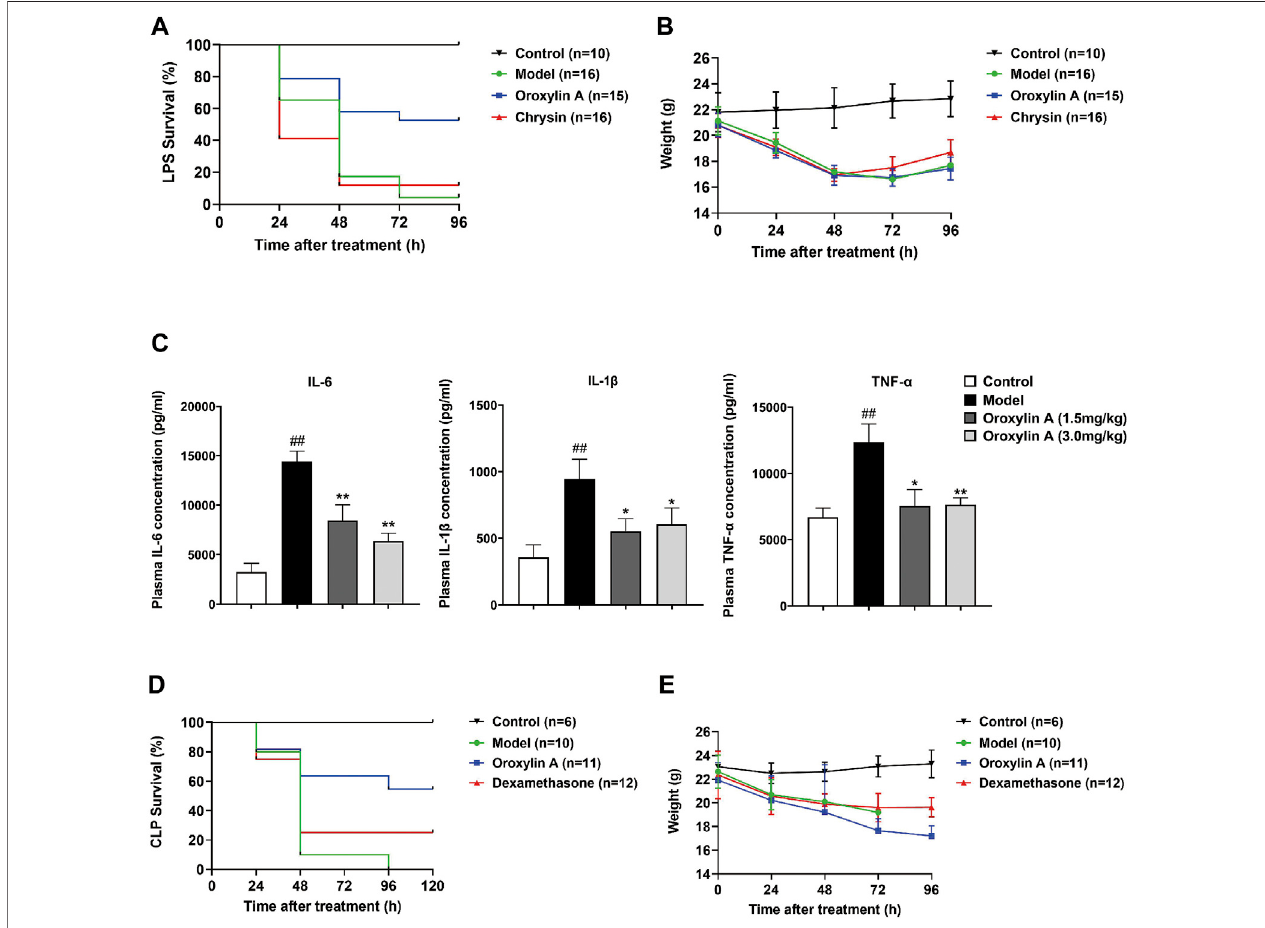
FIGURE 4 | Protection of oroxylin A on endotoxemia mice. (A) Survival rates of LPS-induced endotoxemia mice with administration of oroxylin A and chrysin. (B) BodyweightofLPS-inducedendotoxemiamicewithadministrationoforoxylinAandchrysin. (C) Inhibitoryresponseofpro-in fl ammatorycytokineIL-6,IL-1 β ,andTNF- α inLPS-inducedendotoxemiamiceplasmabydifferentdosesoforoxylinA( n =3).OroxylinAandchrysin(3.0 mg/kg)wereinjectedtomiceeverydayafterLPSchallenge (30 mg/kg, iv).The fi rst-timetreatmentwas30 min priortotheinjectionofLPS. (D) SurvivalratesofCLP-inducedendotoxemia mice withadministration oforoxylin A and dexamethasone. (E) Body weight of CLP-induced endotoxemia mice with administration of oroxylin A and dexamethasone. Oroxylin A and dexamethasone (3.0 mg/kg) were injected 30 min before mice subjected to CLP. Drugs were administrated every day. Data are presented as mean ± SD. ## p < 0.01 vs. control, * p < 0.05 vs. model, ** p < 0.01 vs.